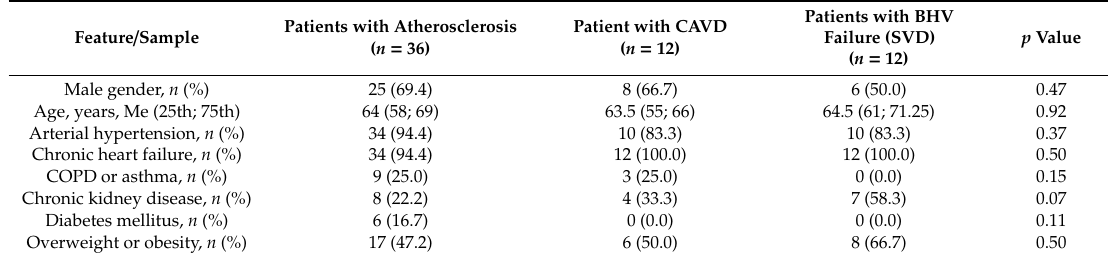
Table 1. Clinicopathological features of the patients with atherosclerosis, CAVD, and BHV failure. Patients with BHV Patients with Atherosclerosis Patient with CAVD Feature / Sample Failure (SVD) ( n = 36) ( n = 12)